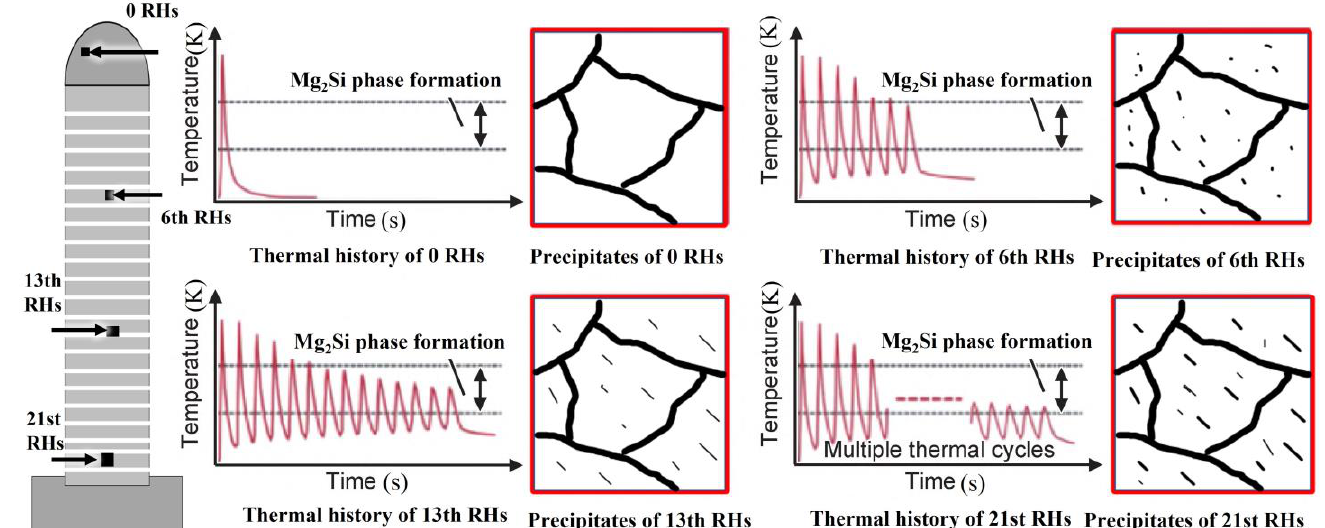
Figure 5. Formation mechanism of the second phase of wire arc additive manufacturing of the 4043- 273 aluminum alloy at different positions. 4043-aluminum alloy at different